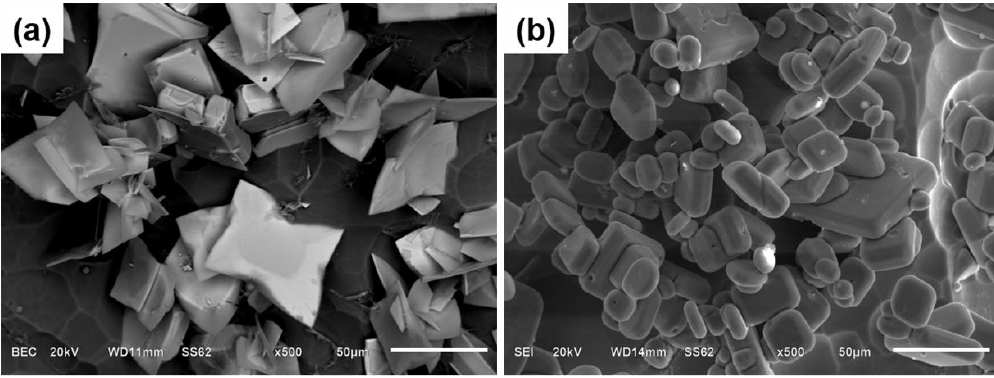
Figure 5. SEM micrographs and diameter distribution of primary Al 3 Zr particles after deeply etching ( a ) without IC-AEMS and ( b ) with IC-AEMS.